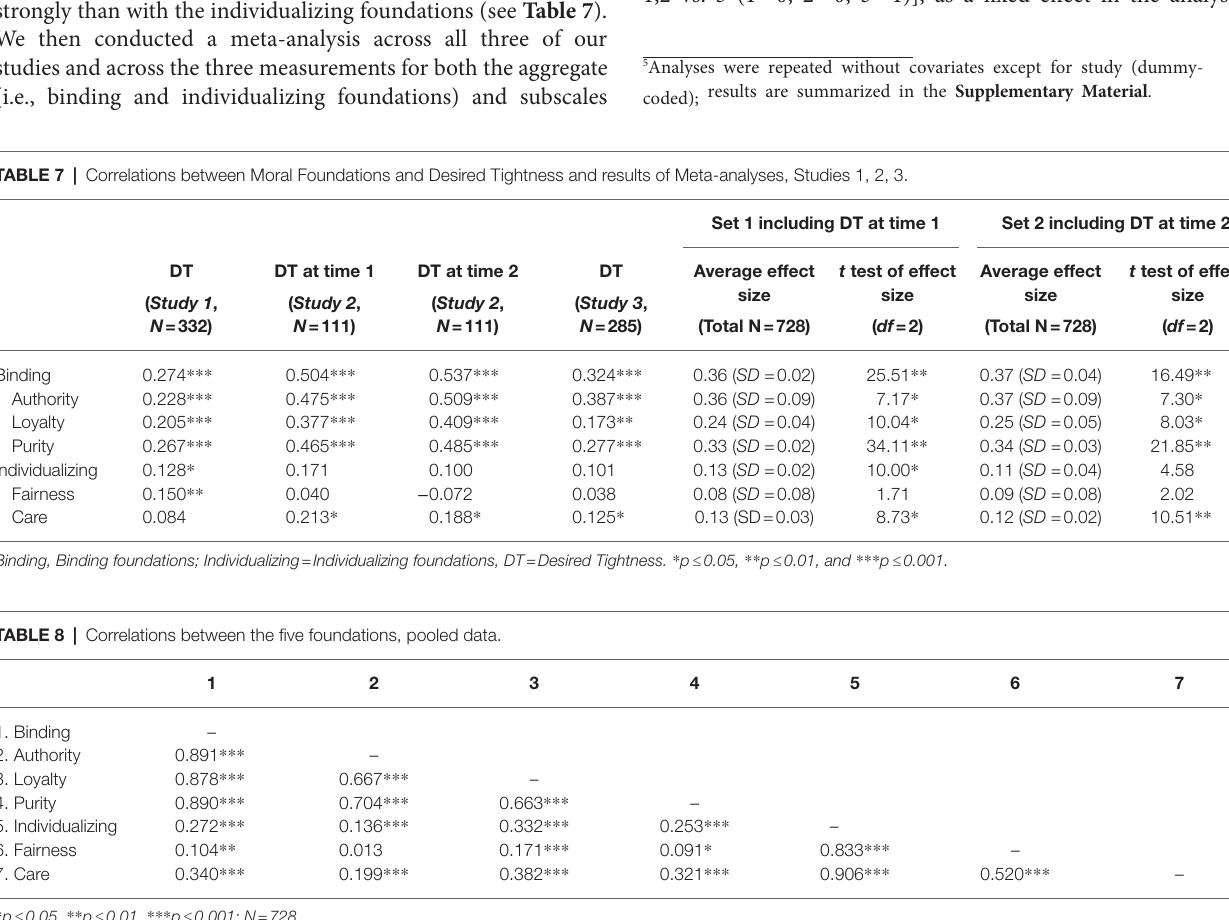
TABLE 7 | Correlations between Moral Foundations and Desired Tightness and results of Meta-analyses, Studies 1, 2, 3.